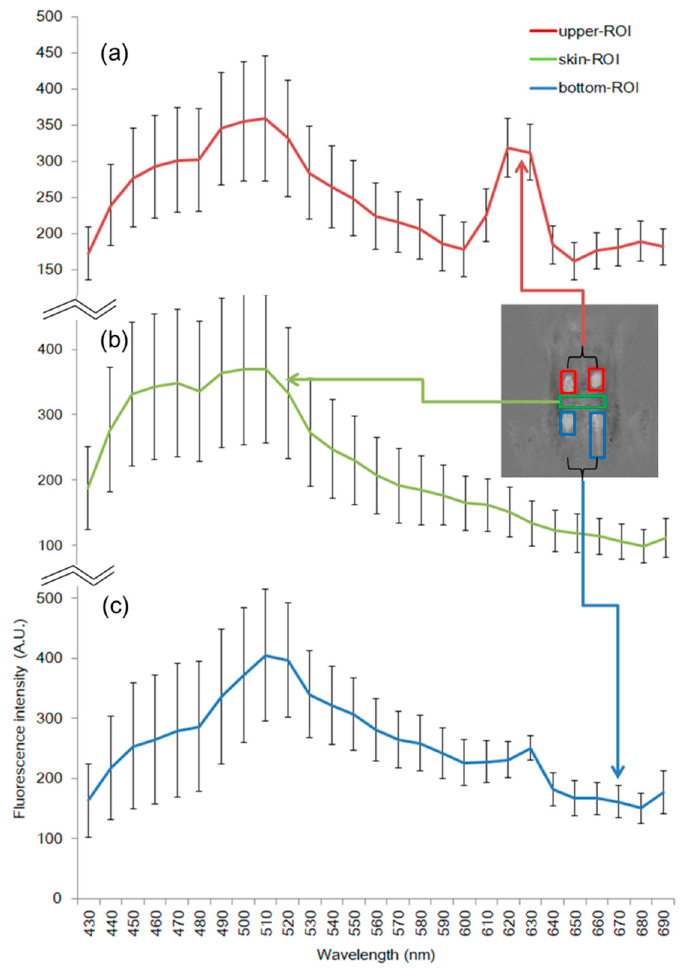
Figure 4. Mean and standard deviation plot of three ROI groups from upper/bottom-ROI (fecal spots) and skin-ROI. Upper-ROI (red line, a ) and bottom-ROI (blue line, b ) represent ceca, colon spots, and small intestine, duodenum spots. Skin-ROI (green line, c ) covers up whole pixels of skin image.